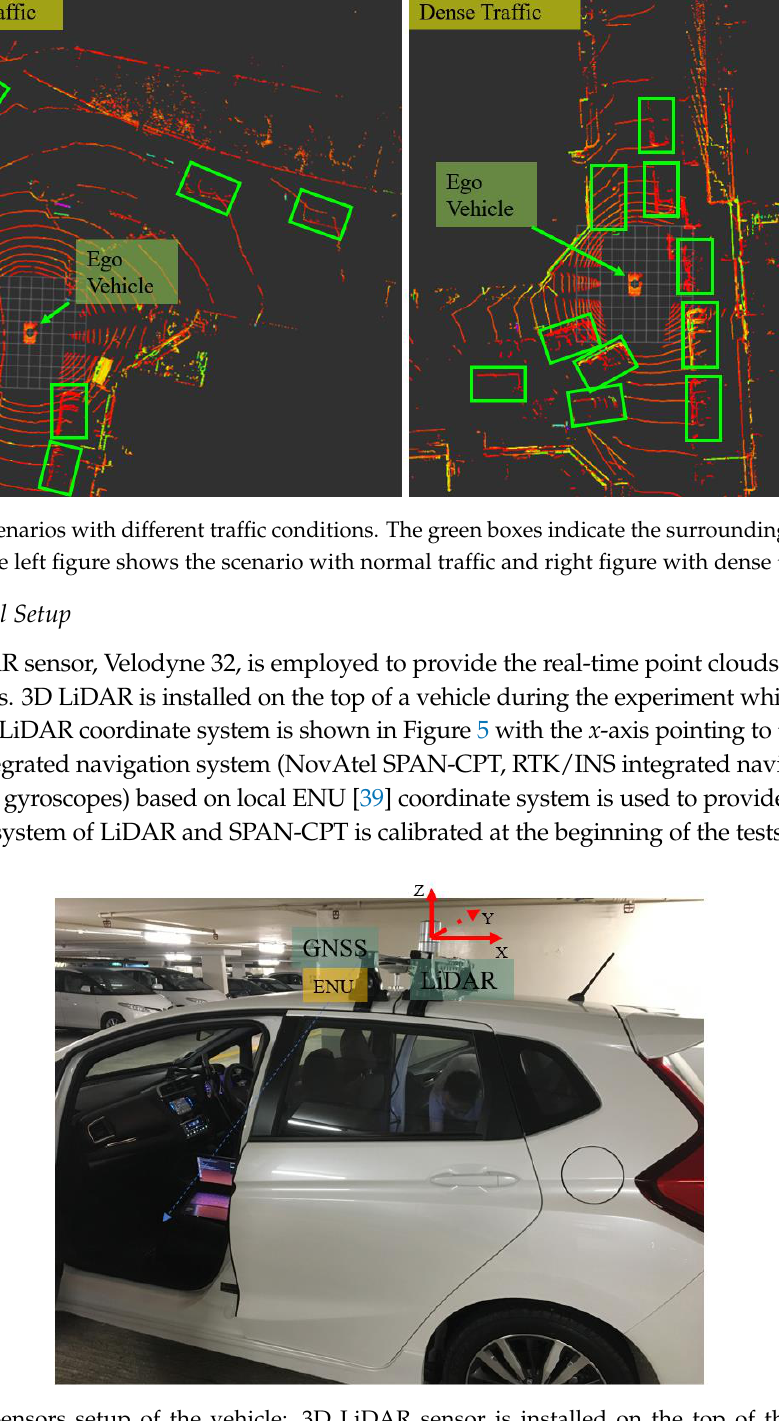
Figure 5. Sensors setup of the vehicle: 3D LiDAR sensor is installed on the top of the vehicle. GNSS 268 RTK/INS integrated navigation system is installed on the top of the vehicle next to 3D LiDAR. The 269 GNSS RTK/INS in ENU coordinate system is used to provide the ground truth of vehicle’s position. 270